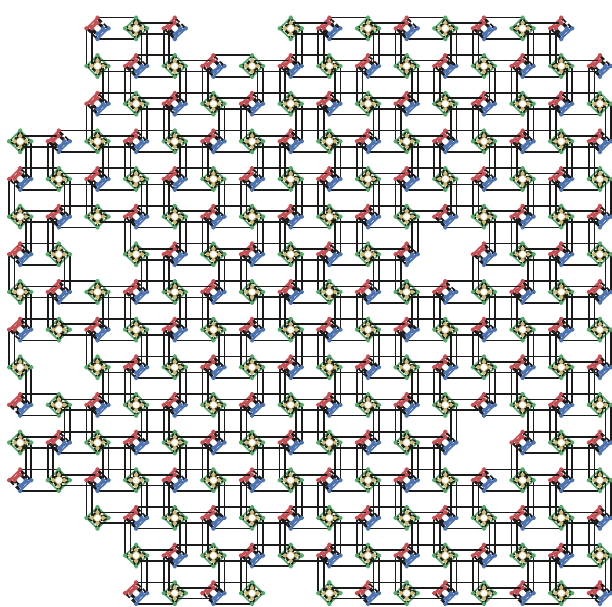
FIG. 5. Half-cell embedding into the D-Wave quantum annealer with unit cell as depicted in Fig. 1(b). This is rotated 45 ◦ to obtain the lattice shown in Fig.